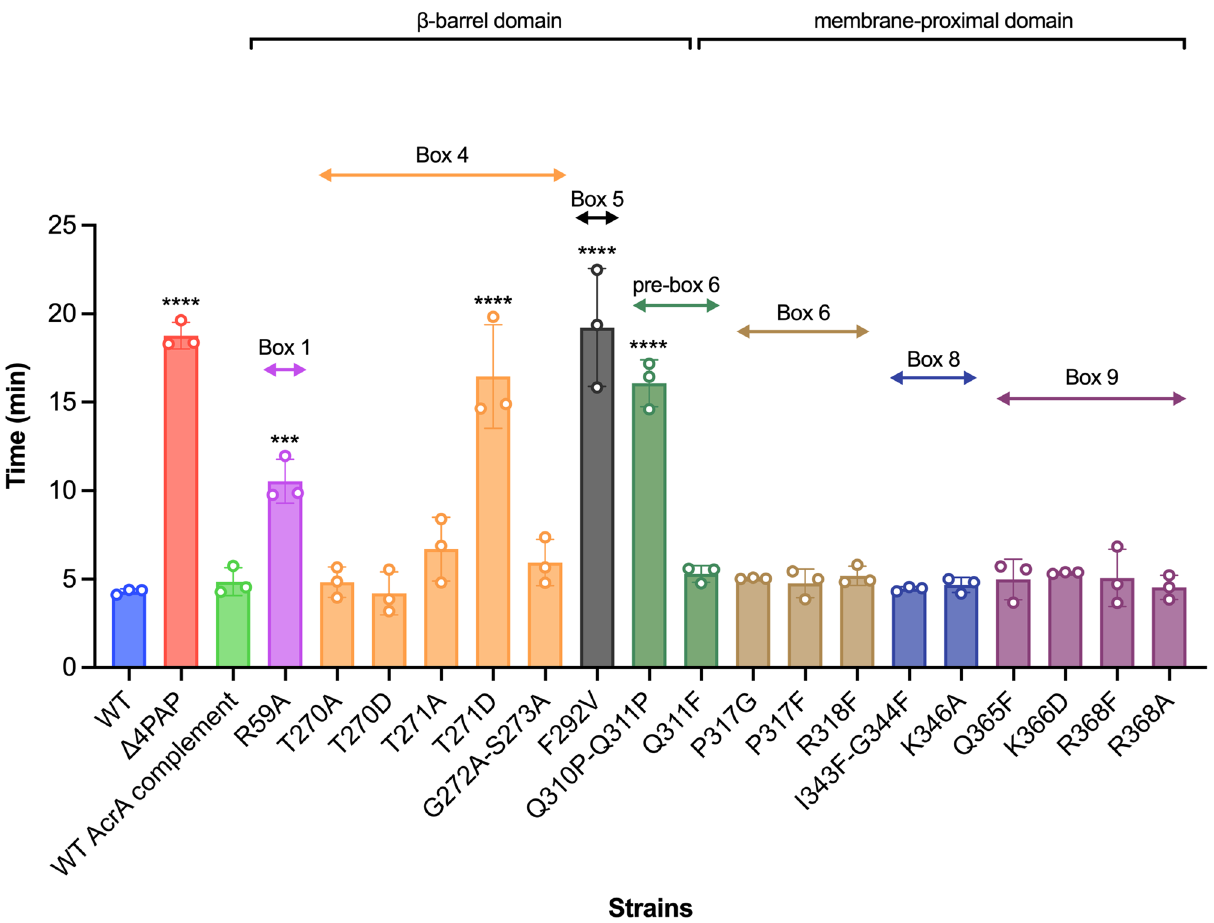
Figure 2. Efflux of ethidium bromide by the Salmonella Typhimurium SL1344 Δ4PAP strain complemented with mutated versions of AcrA. Data presented are the mean of three biological replicates and are shown as the time taken for the fluorescence to decrease by 25% ± standard deviation. Bacteria were treated with ethidium bromide and the proton-motive force dissipator CCCP for 1 h and then re-energised with glucose. The annotation above indicates the mapping of each mutation to its binding box and the domain mapping of respective boxes. Data were analysed by one-way ANOVA and compared to the WT AcrA complement using Dunnett’s test. Strains with significantly different efflux are indicated with *** ( P ≤ 0.001) or **** ( P ≤